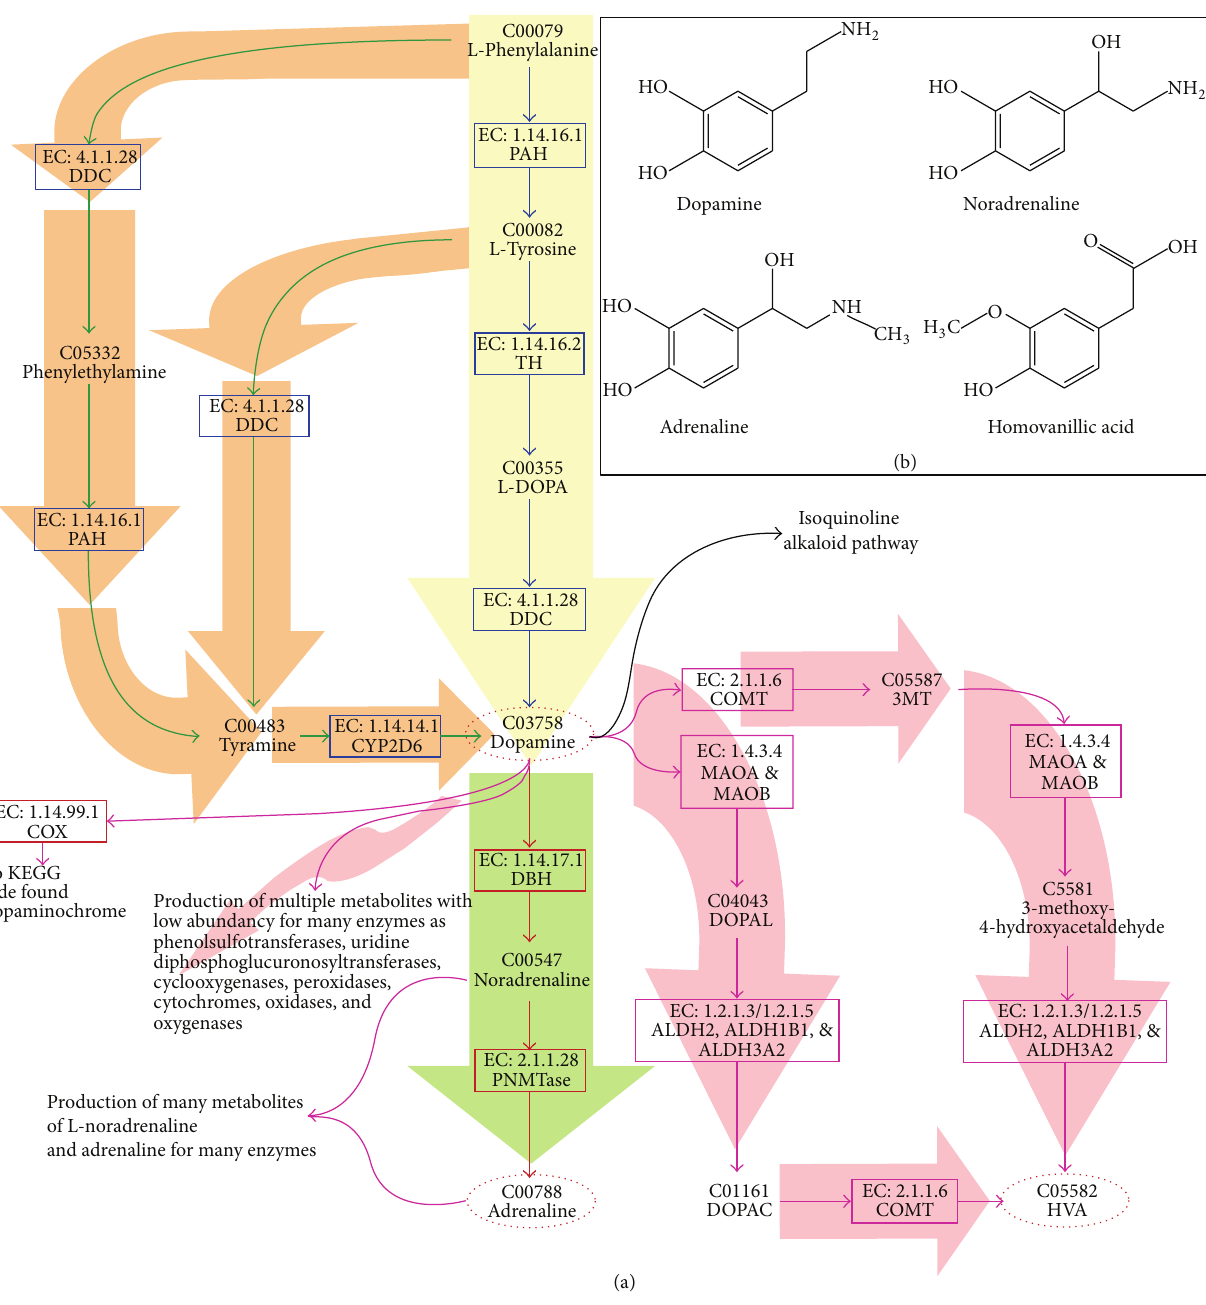
Figure 1: Metabolic pathways associated with DA. The metabolic pathways branching from the catabolism of L-phenylalanine are shown. (a) Thedarkbluearrows(overlightyellowbranches)indicatetheDAgenerationpathway,andtheredarrows(overlightgreenbranches)represent the noradrenaline and adrenaline pathway. Green arrows (over orange branches) show the alternative synthesis pathways to dopamine. The magenta arrows (over pink branches) show dopamine catabolism; the right side shows the normal pathways converging on HVA; the left side shows the catabolic pathways when dopamine concentrations are high in the cytoplasm. Many enzymes can transform dopamine and metabolites, such as COX enzymes (cyclooxygenases), producing dopaminochrome and dopamine quinone [44]. Other enzymes can produce sulfur and glucuronide derivatives. (b) The inset shows the most important products (circled with dotted lines) of metabolic pathways associated with DA. The compounds in these pathways are denoted by Kyoto Encyclopedia of Genes and Genomes (KEGG) code (http://www.genome.jp/kegg/). Enzymes with their classification codes (EC, http://www.chem.qmul.ac.uk/iubmb/enzyme/) and UNIPROT gene names are shown in